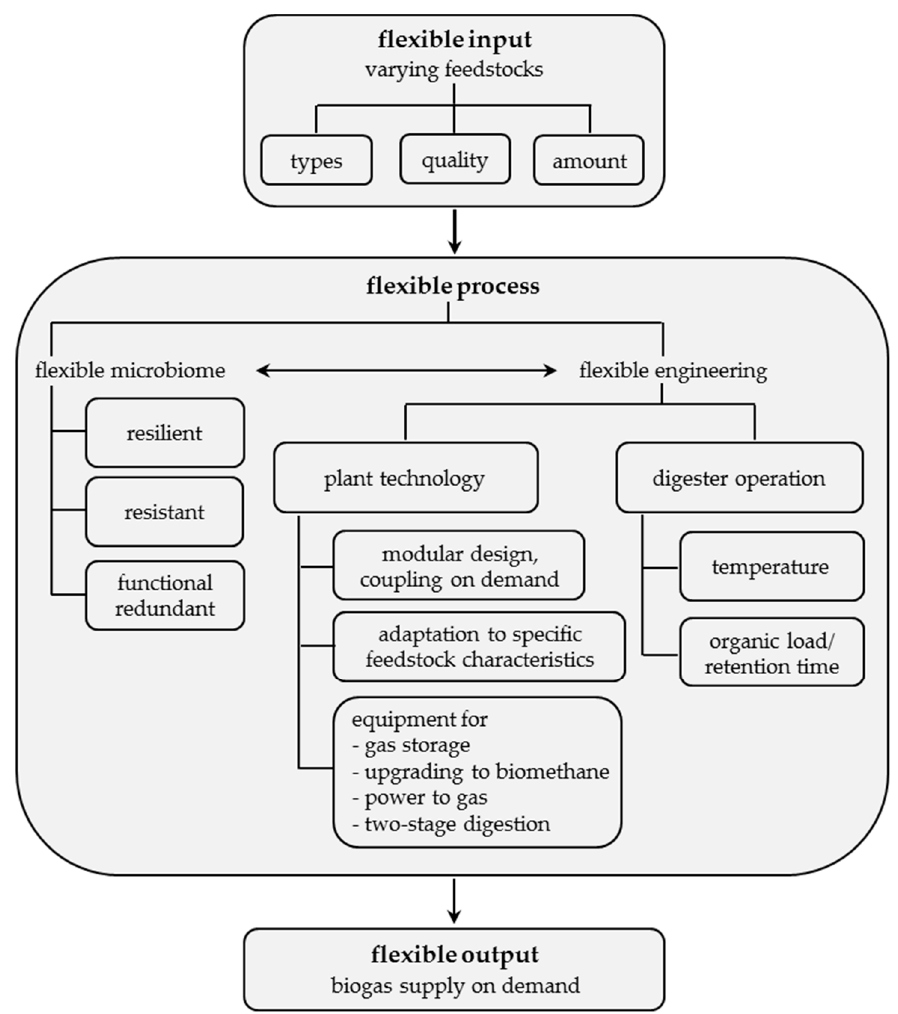
Figure 3. Components of flexible biogas plants.